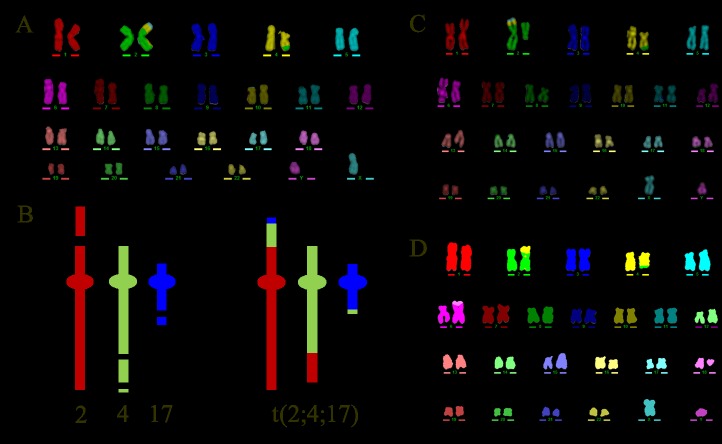
M-FISH karyotype of clonal complex exchange.M-FISH karyotype (A) and cartoon (B) showing the clonal complex exchange t(2;4;17) that was observed Td populations previously exposed to 0.5 Gy α-particles. The minimum number of chromosome breaks required to form the observed exchange are shown. Representative M-FISH karyotypes of the clonal complex that also contain additional non-clonal abnormalities such as chromosome breaks (del(2q) (B)) and simple translocations (t(6;18) (C)).